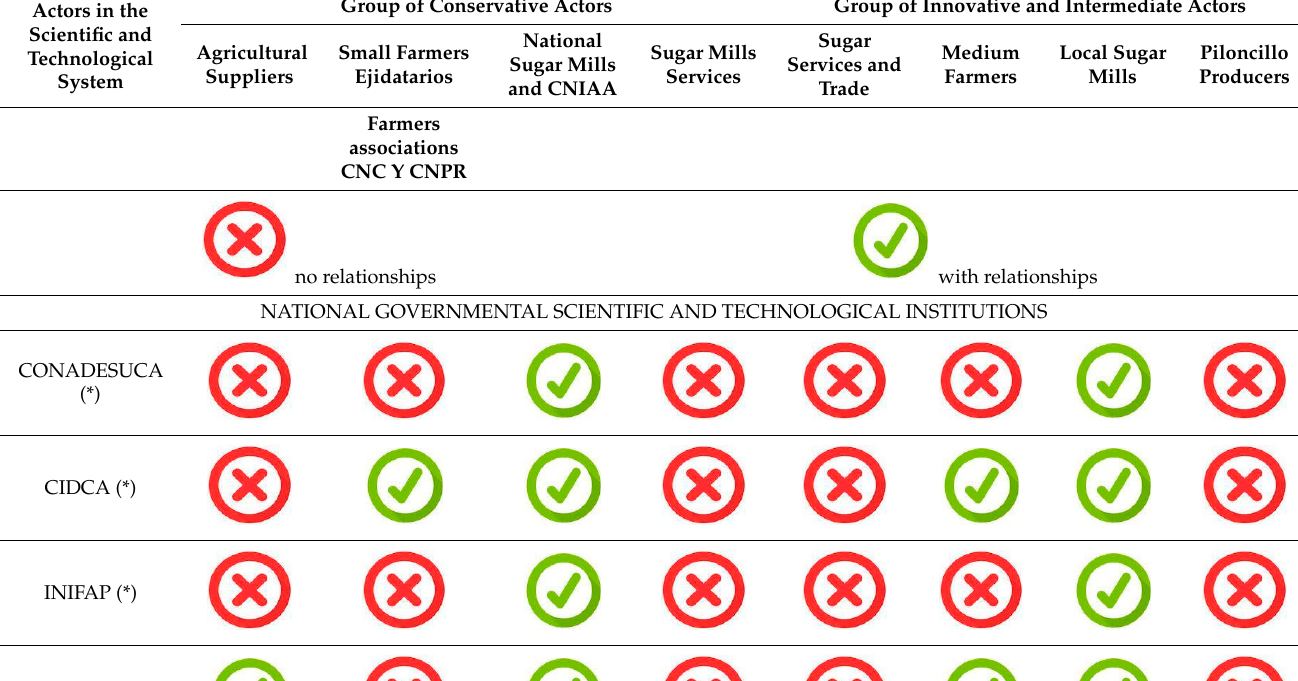
Table 3. Relations of R&D system with the conservative, intermediate and innovative network actors.